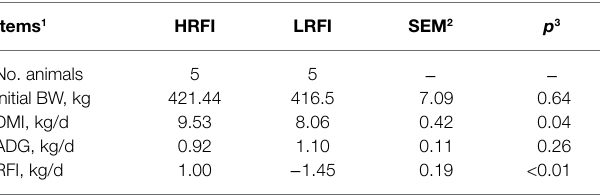
TABLE 1 | Animal performance according to residual feed intake (RFI)